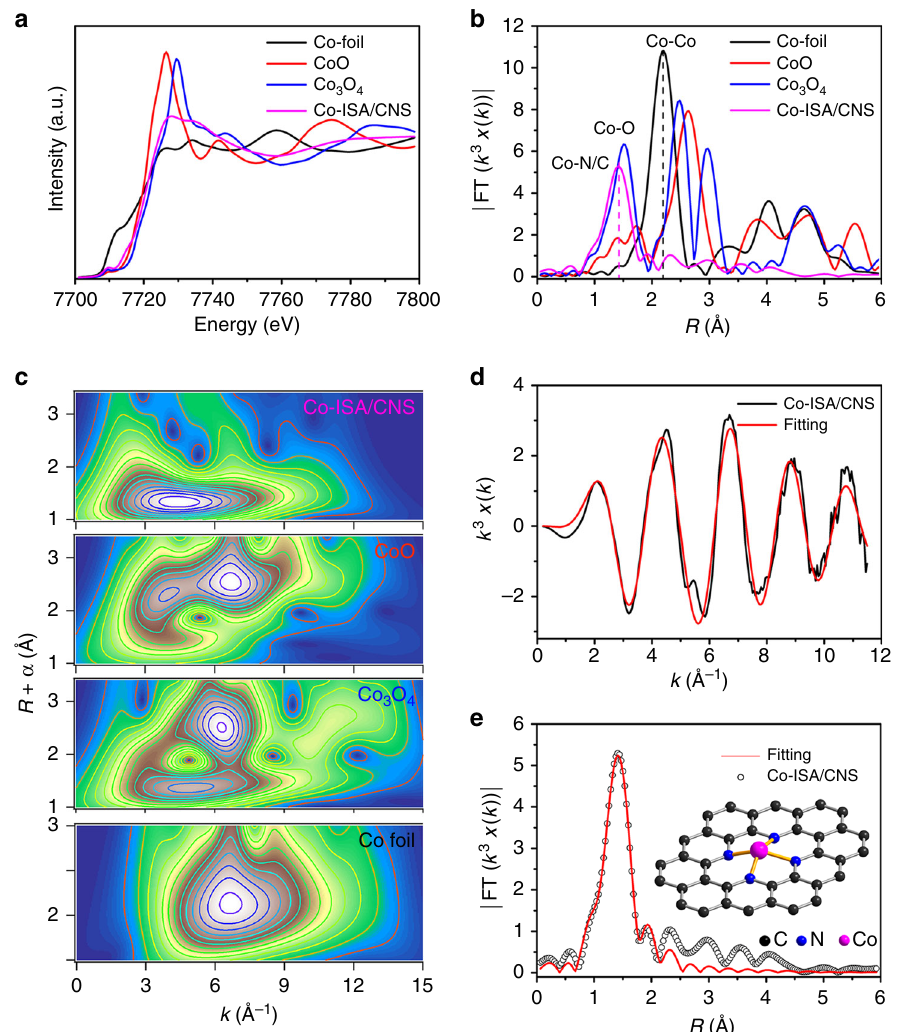
Fig. 2 Synchrotron XAFS measurement of Co-ISA/CNS catalyst. a Co K-edge XANES spectra of Co-ISA/CNS catalyst and reference samples. b Fourier transformed (FT) k 3 -weighted χ ( k )-function of the EXAFS spectra for Co K-edge. c Wavelet transforms for the k 3 -weighted EXAFS signals. d , e Corresponding EXAFS fi tting curves at k and R space, respectively, inset showing the schematic